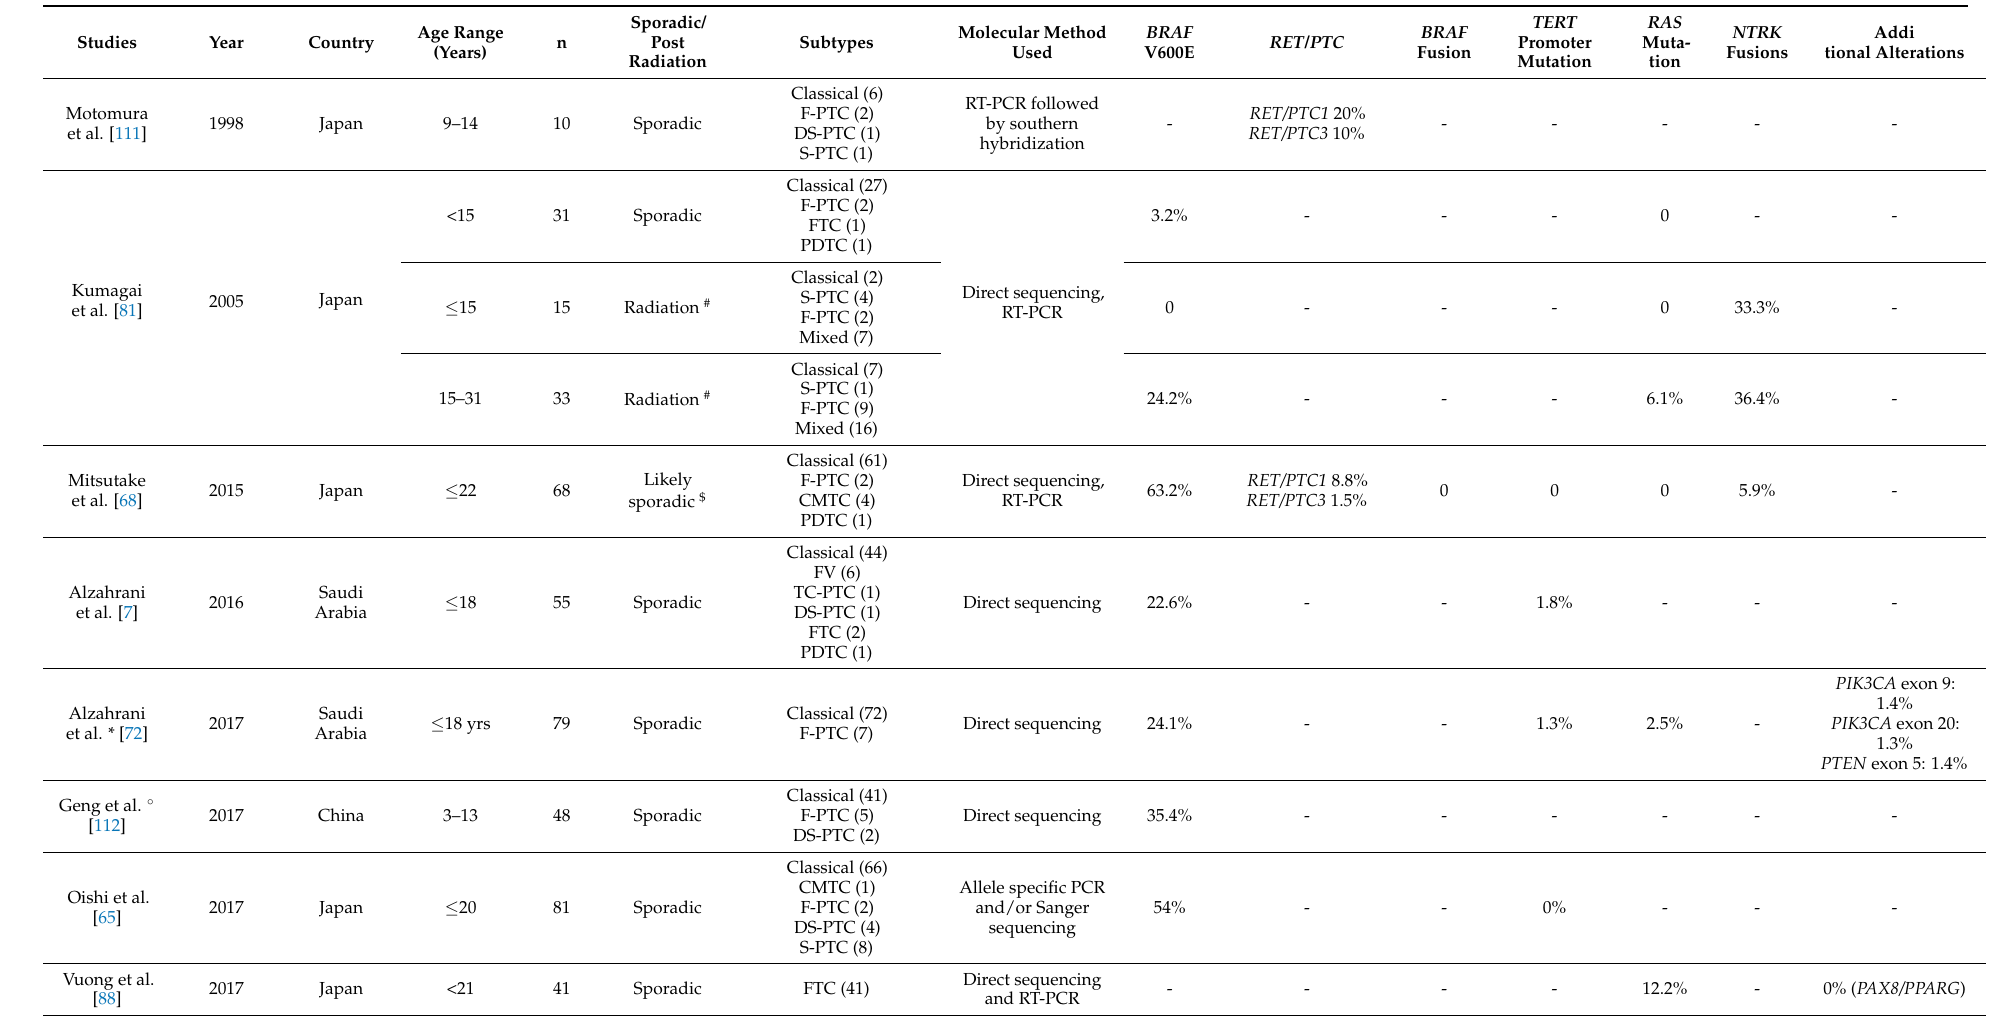
Table 2. Studies from Asian countries with details of genetic alterations in pediatric